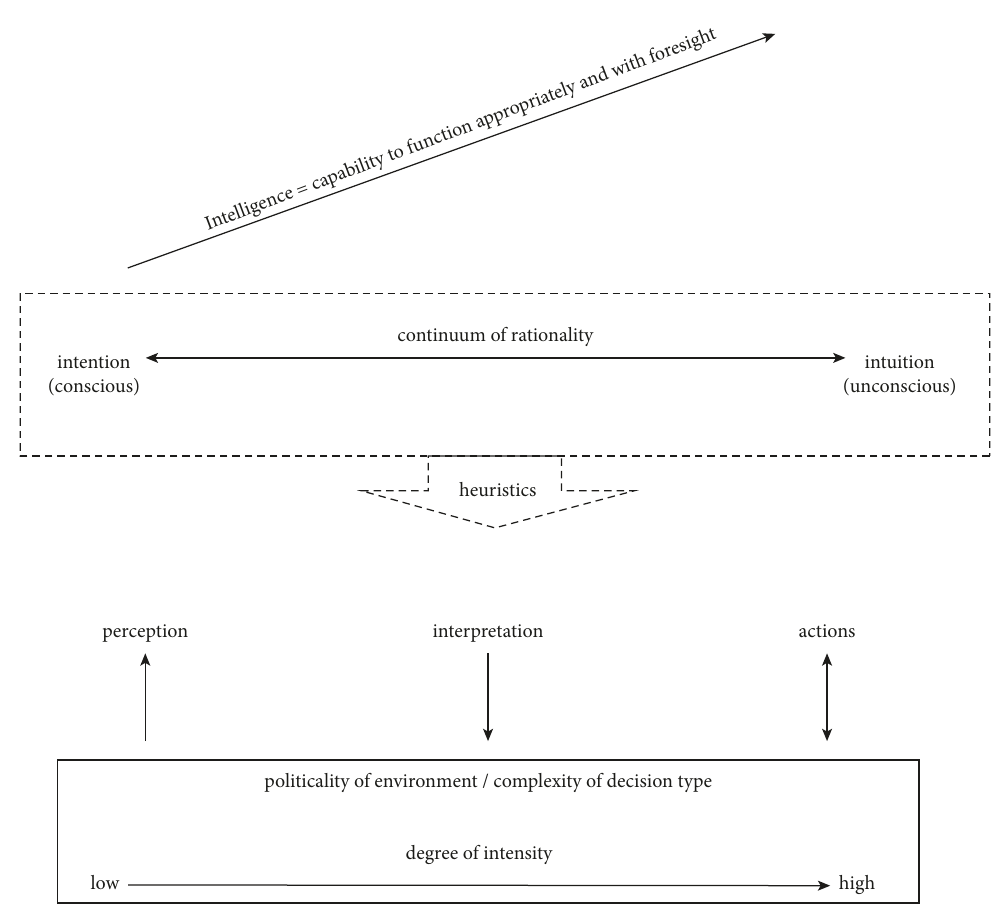
Figure 4: Continuum of rational behavior. Table 1: Categorization of publications based on organizational environment and the implementation of AI component. Feature of AI